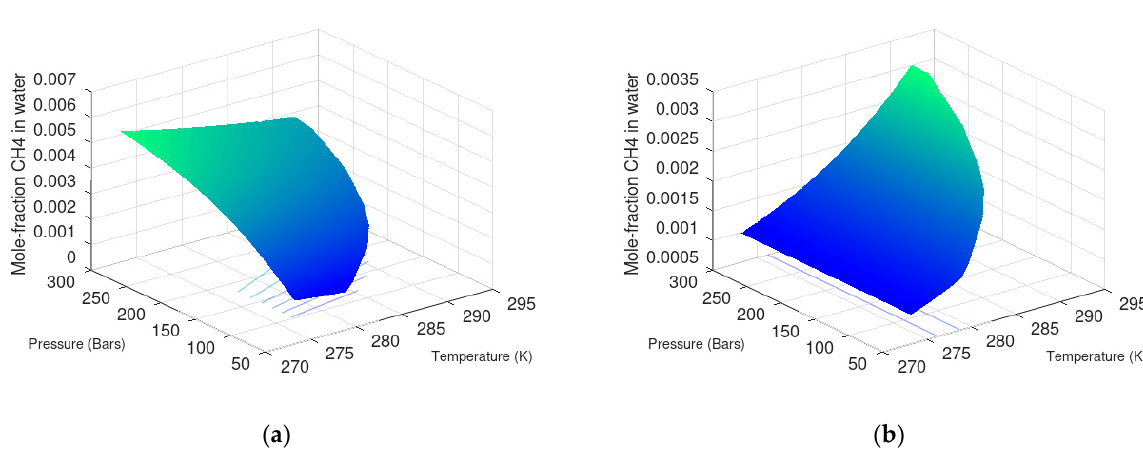
Figure 14. Solubility of CO 2 in water containing 3 mole percent ethanol and hydrate stability limits for CO 2 . ( a ) Solubility of CO 2 in water for the range of hydrate forming conditions. ( b ) Hydrate stability limit concentrations for CO 2 .